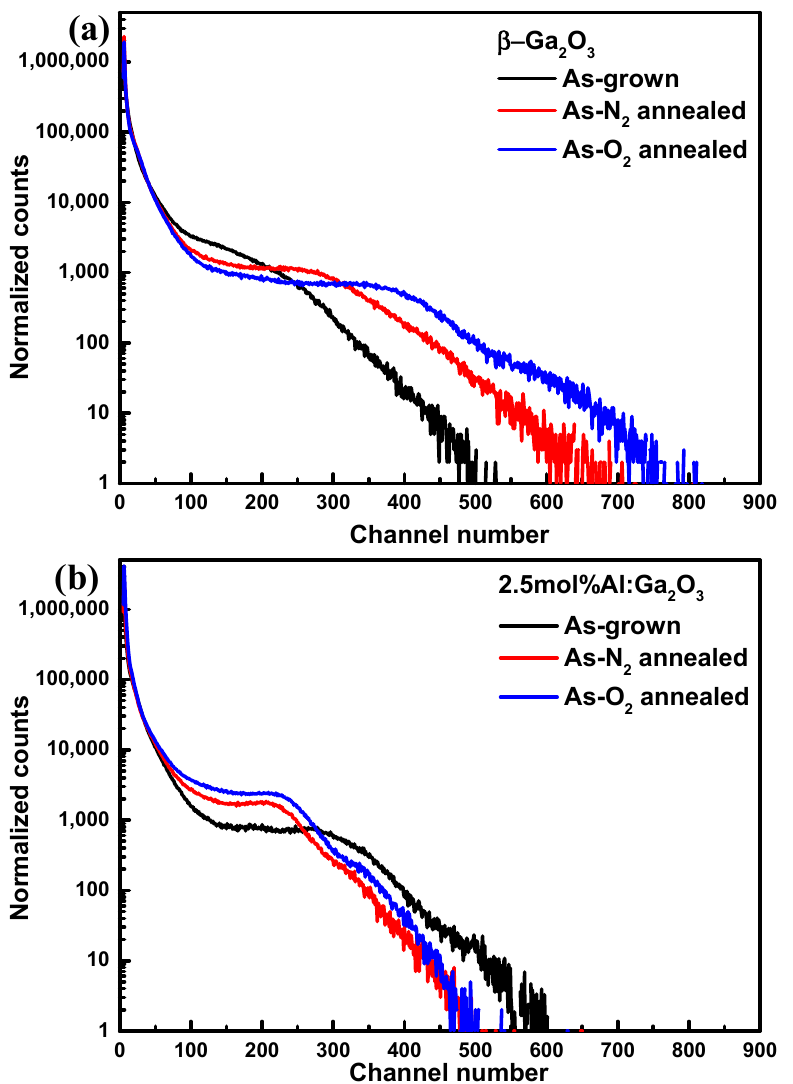
Figure 5. Pulse height spectra profiles of ( a ) undoped β -Ga 2 O 3 and ( b ) 2.5 mole% Al-doped β -Ga 2 O 3 crystal.